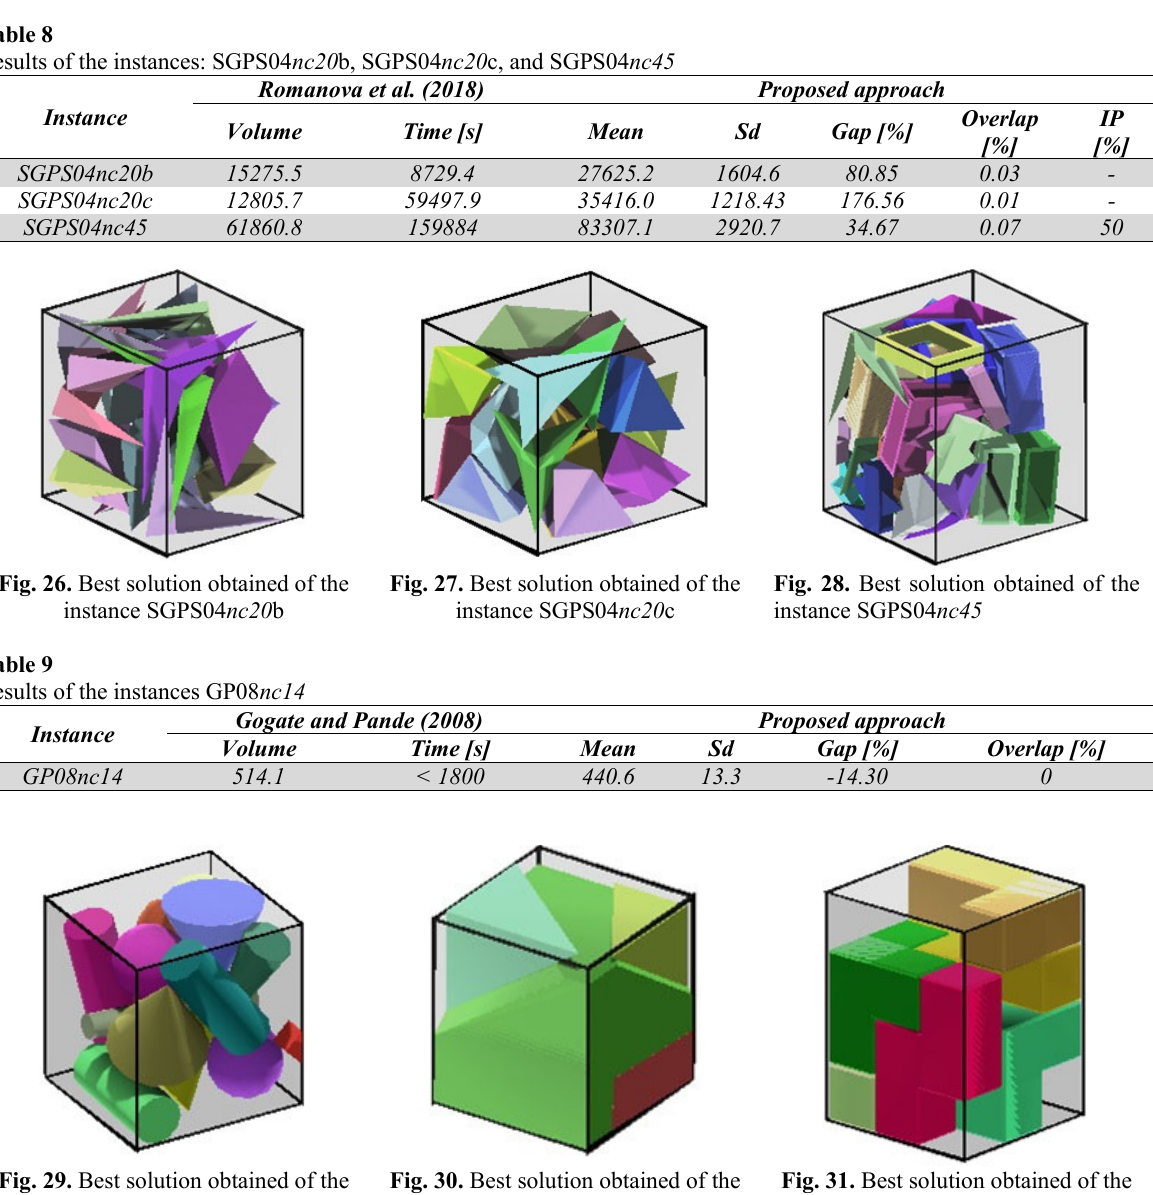
Fig. 24. Best solution obtained of the instance SGPS04 nc50 Fig. 25. Best solution obtained of the instance LLCY15 nc36